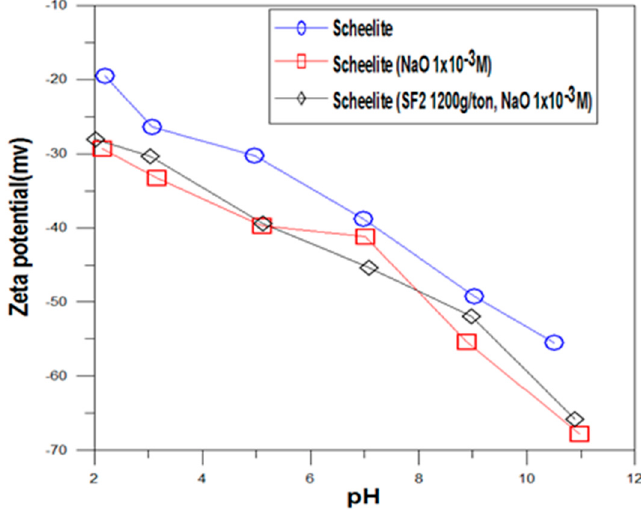
Figure 6. Zeta potentials of scheelite with and without the collector and depressant. Minerals 2020 , 10 , x FOR PEER REVIEW